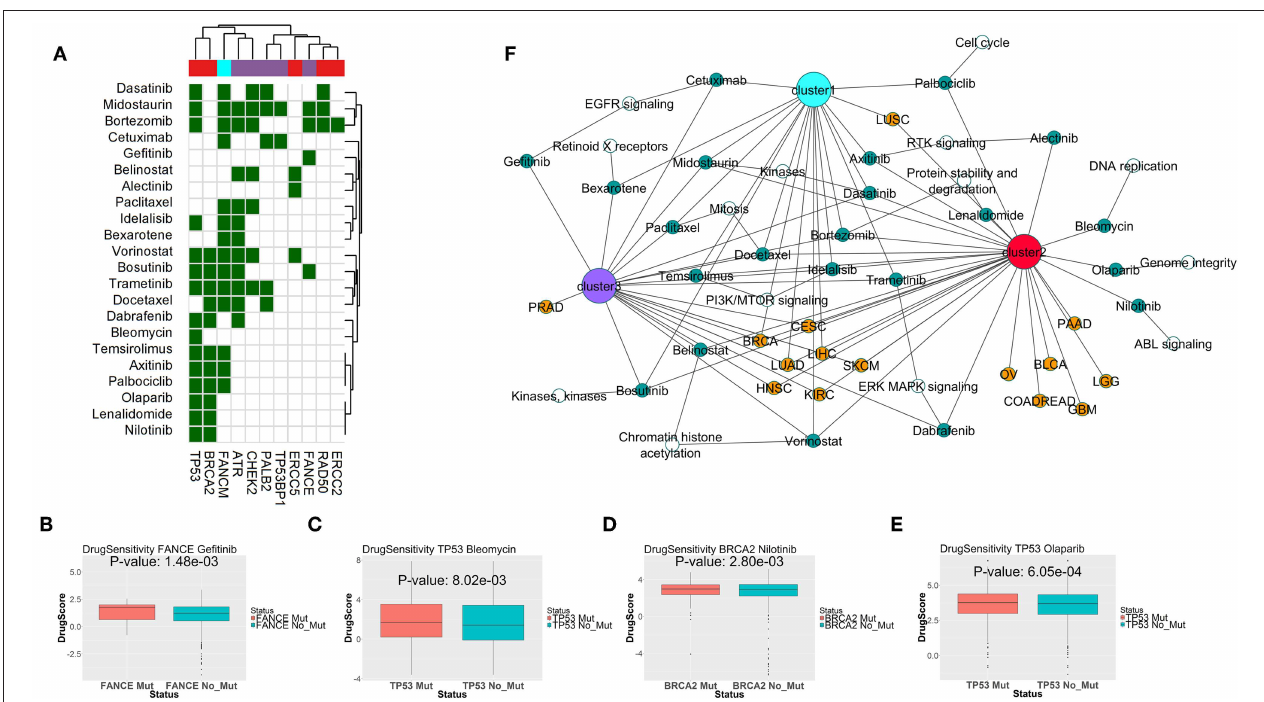
FIGURE 6 | (A) Drugs targeting predicted synthetic lethal partners for gene mutations specific to each DDR cluster, that have conditional sensitivity in presence of the corresponding gene mutations as observed from cancer cell line drug screening data from GDSC portal. In the matrix, color coding of each cell denotes whether the corresponding drug (in y-axis) is sensitive to mutations in the corresponding DDR gene (in x-axis). The column color labels annotate the DDR clusters where mutations in the corresponding DDR gene is prevalent. (B–E) Sensitivities of Gefitinib in presence of FANCE mutation, Bleomycin in presence of TP53 mutation, Nilotinib in presence of BRCA2 mutation, and Olaparib in presence of TP53 mutation; as seen from cancer cell lines in GDSC portal. The DrugScore in the y-axis represents LN IC50 values of the drugs in the cell lines with/without mutation in the corresponding DDR genes. (F) Association network of predicted synthetic lethal genes of gene mutations specific to each DDR cluster across TCGA tumor types, and potential drugs targeting the synthetic lethal genes which are also sensitive to mutations in the primary DDR gene. The following color coding is applied; tumor types: red, DDR gene mutations specific to DDR cluster 1: cyan, DDR gene mutations specific to DDR cluster 2: pink, DDR gene mutations specific to DDR cluster 3: purple, synthetic lethal genes: white and drugs: